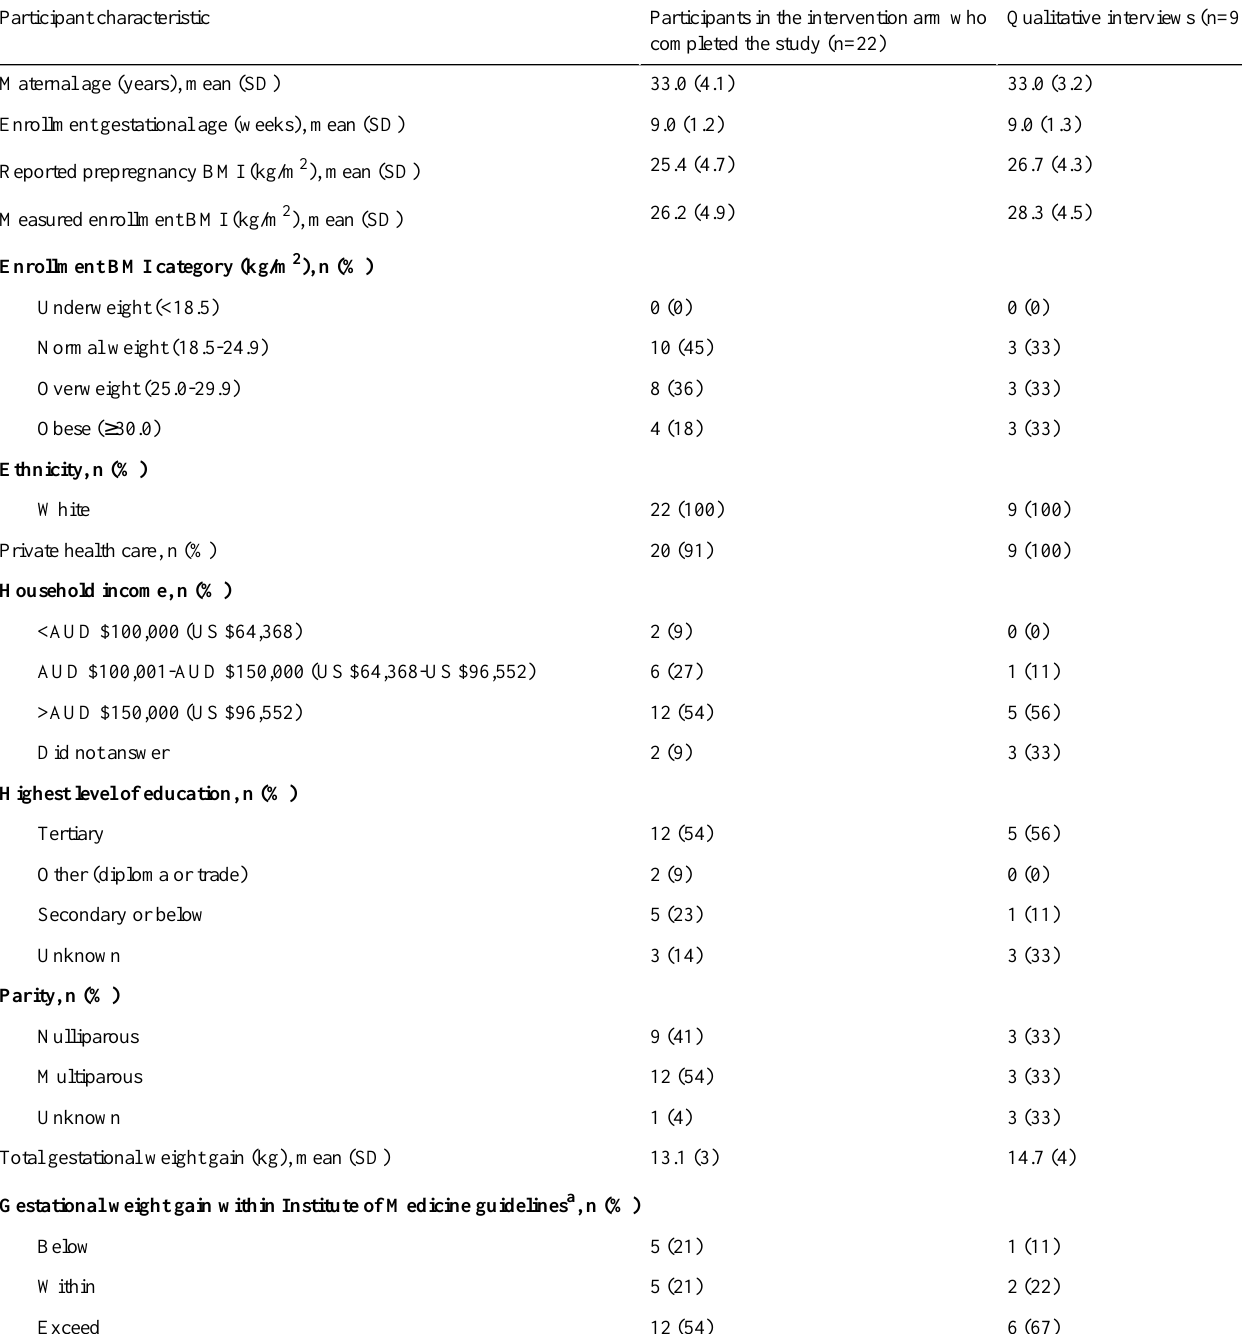
Table 1. Characteristics of participants in the active Pregnancy Lifestyle Activity and Nutrition intervention arm and qualitative interviews. (n=22)Participant